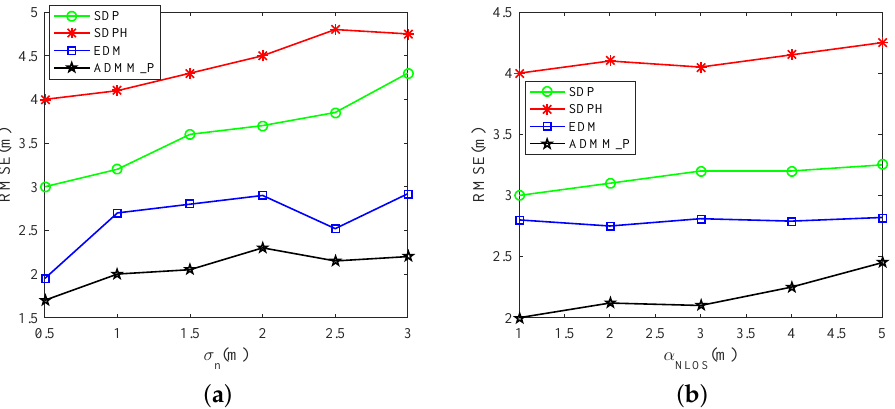
Figure 4. Performance comparison in varying environments with a M = 10, N = 40 sensor network. Probability of NLOS connections was set to P NLOS = 95%. ( a ) Root Mean Square Error (RMSE) comparison in varying noise environments; ( b ) RMSE comparison with different NLOS